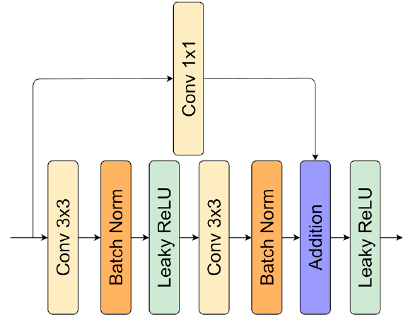
Figure 3. Residual layer representation.